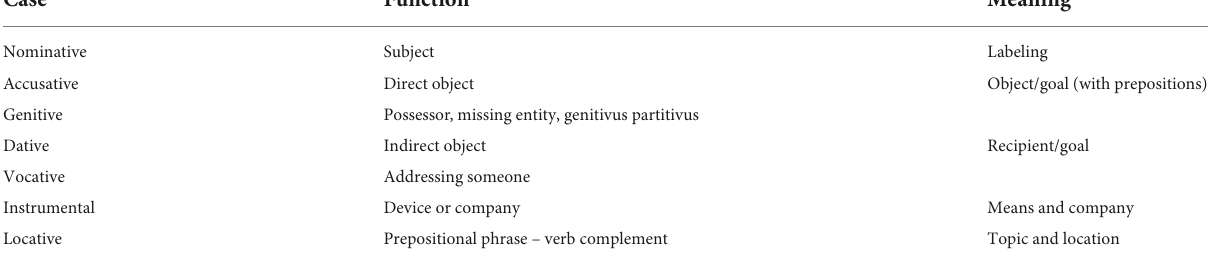
TABLE 1 Cases in Bosnian and their prototypical function and